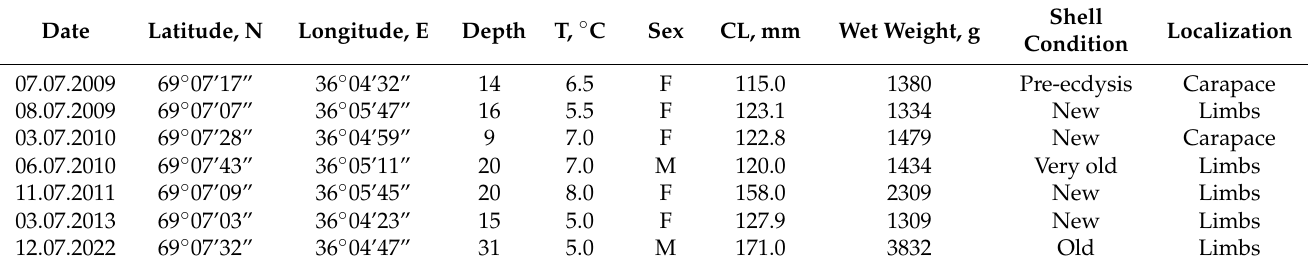
Table 1. Information regarding findings and localization of Coryne hincksi on red king crabs in Zelenetskaya Bay, southern Barents Sea, 2009–2022. Biological data for crabs (size, weight, and shell condition) are provided.